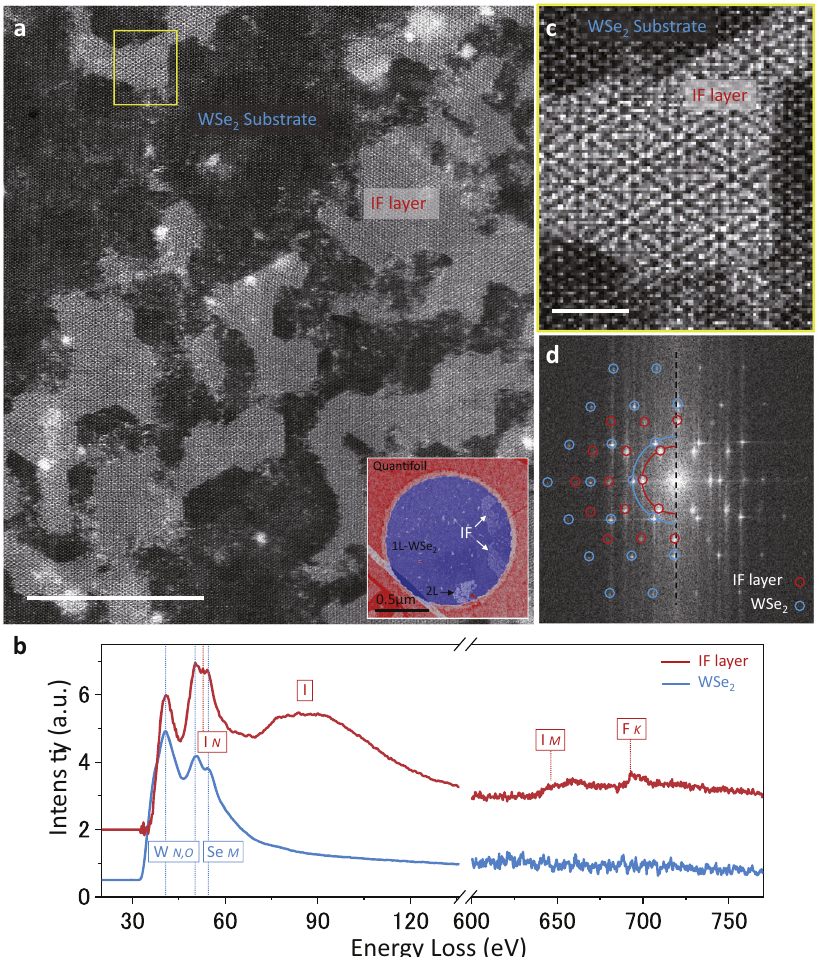
Fig. 2 STEM and EELS characterization of 2D IF layer. a A STEM-ADF image of IF layer is grown on WSe 2 substrate. The scale bar is 20 nm. b EEL spectra of the IF layer (red spectrum) and WSe 2 substrate (blue spectrum) taken from the brighter layer and the dark region in ( a ), respectively. c A closeup of the yellow rectangle area in ( a ), which shows a moiré pattern of the surface IF layer with the WSe 2 substrate. The scale bar is 2 nm. d An FFT pattern of the whole image in ( a ), where the left part marked with red and blue circles in the diffraction spots showing a clear epitaxial relationship of the surface IF layer and the WSe 2